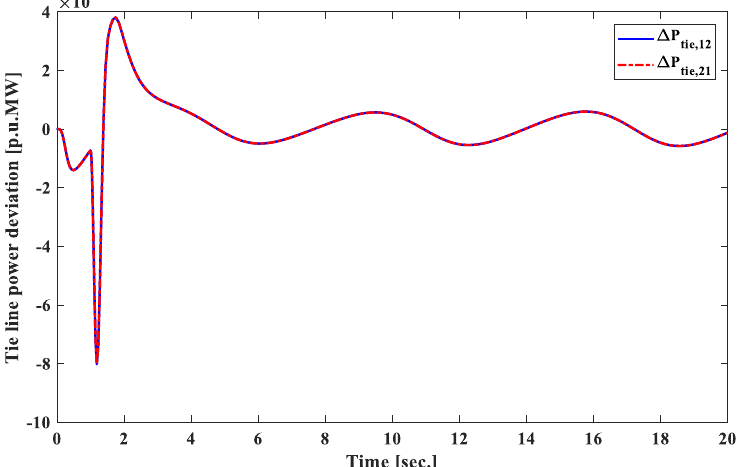
Figure 13. Tie-line power [p.u.MW] of control areas 1 and area 2 under mismatched disturbances.